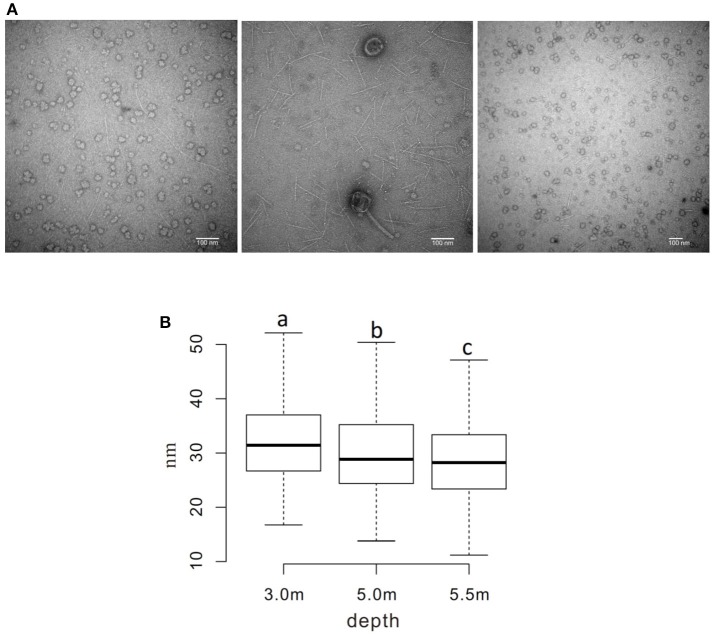
Measurement of the diameter of viral particles. (A) TEM photos of viral samples at each sampling depth (left to right: 3.0, 5.0, and 5.5 m) (B) Boxplot of measured diameters. a−cDiameters without a common superscript differed (P < 0.05).